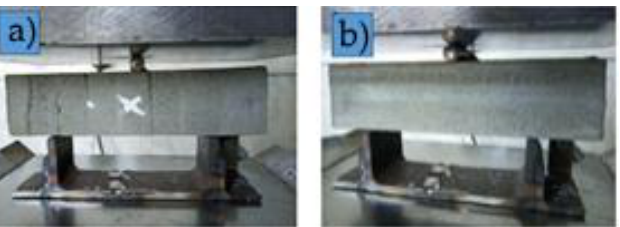
Figure 6. Determination of the flexural strength of printed specimens with loading: ( a ) along horizontal layers; and ( b ) perpendicular to horizontal layers.